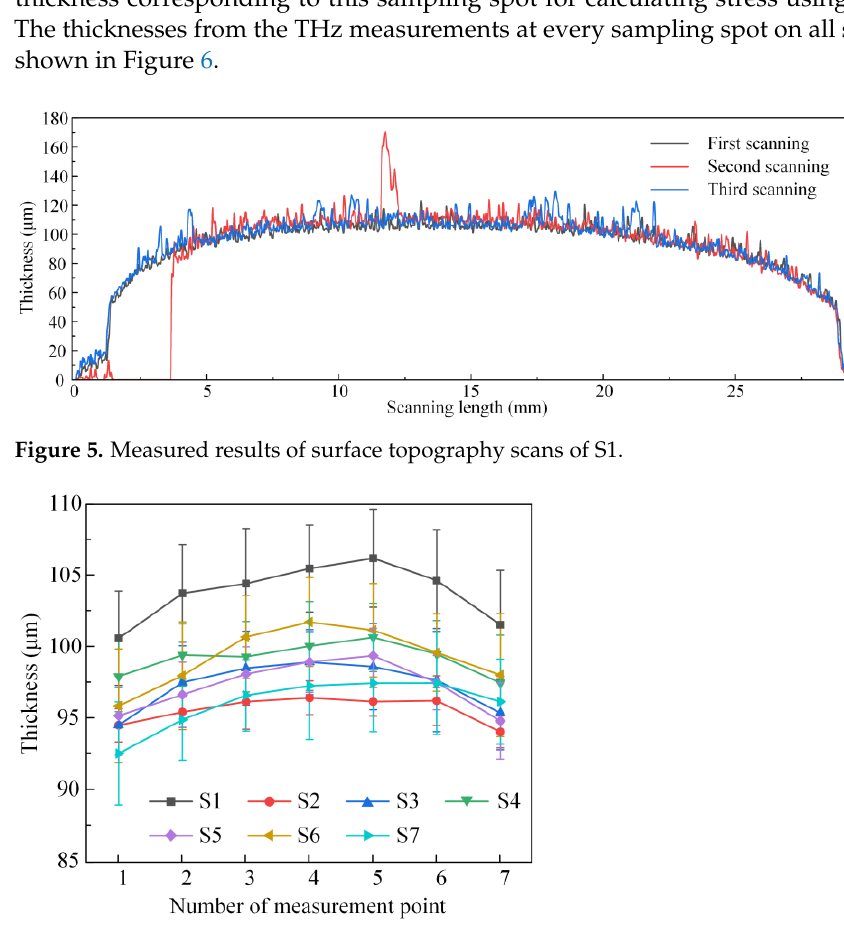
Figure 5. Measured results of surface topography scans of S1.